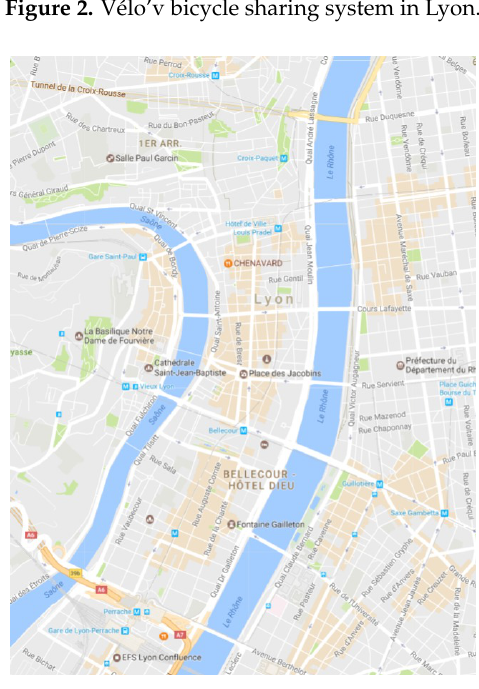
Figure 3. Considered area of